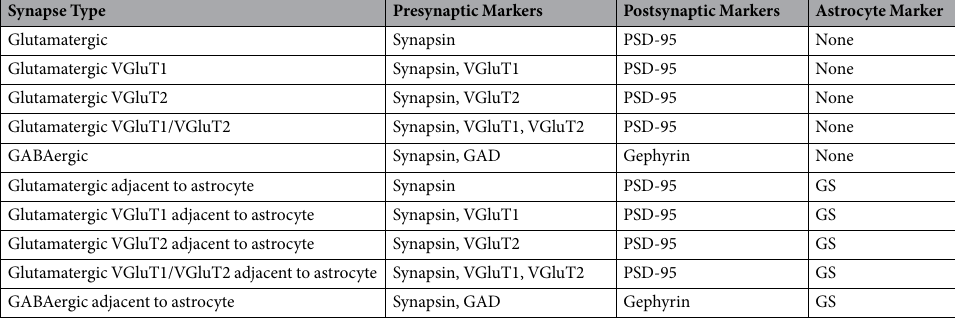
Table 2. Queries used for this